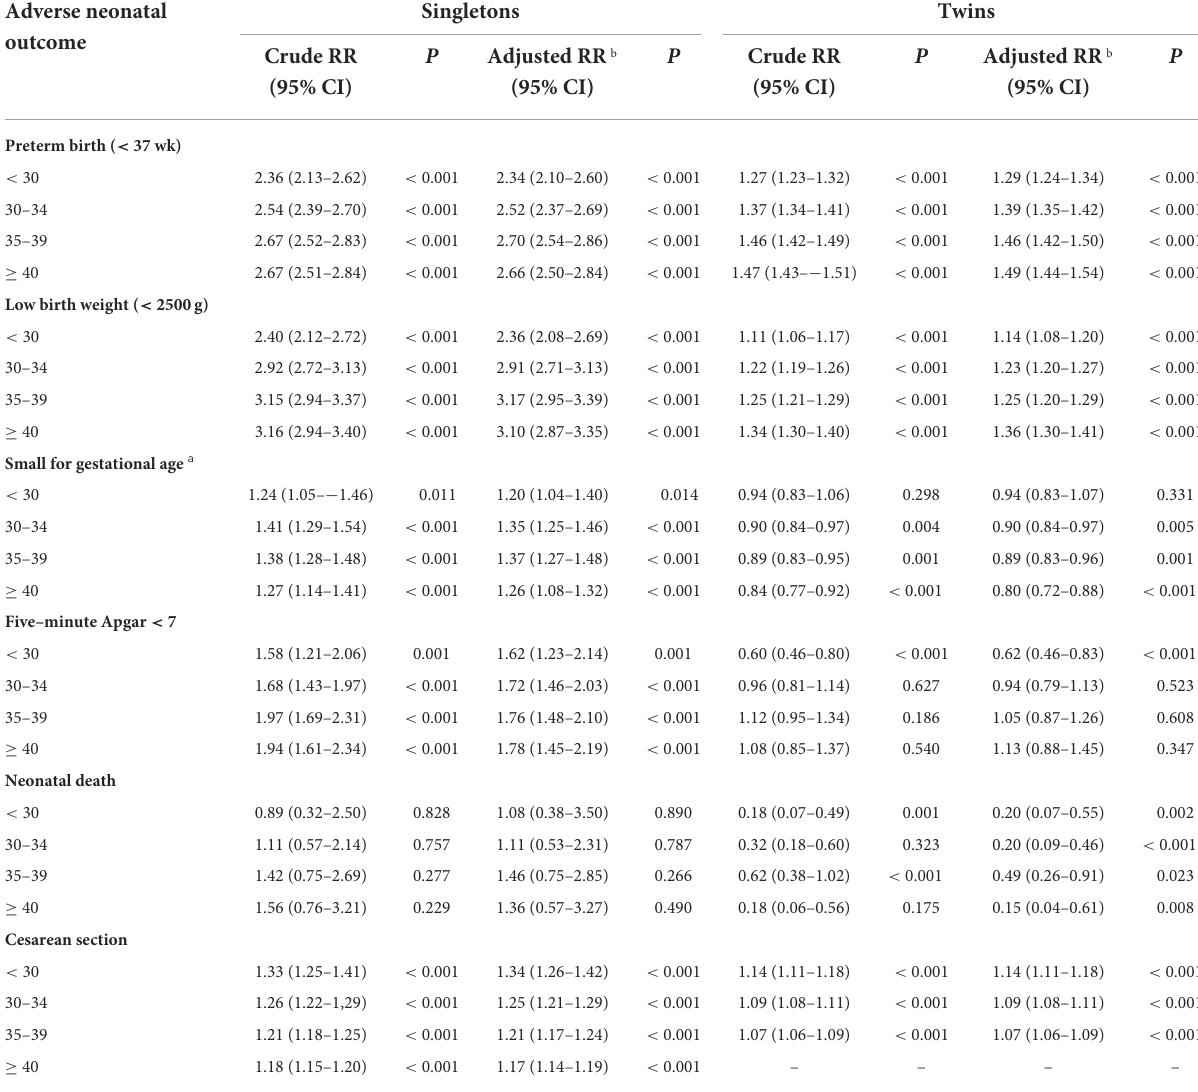
TABLE 3 Stratified analysis for the association of HDP and adverse neonatal outcomes in ART mothers by age